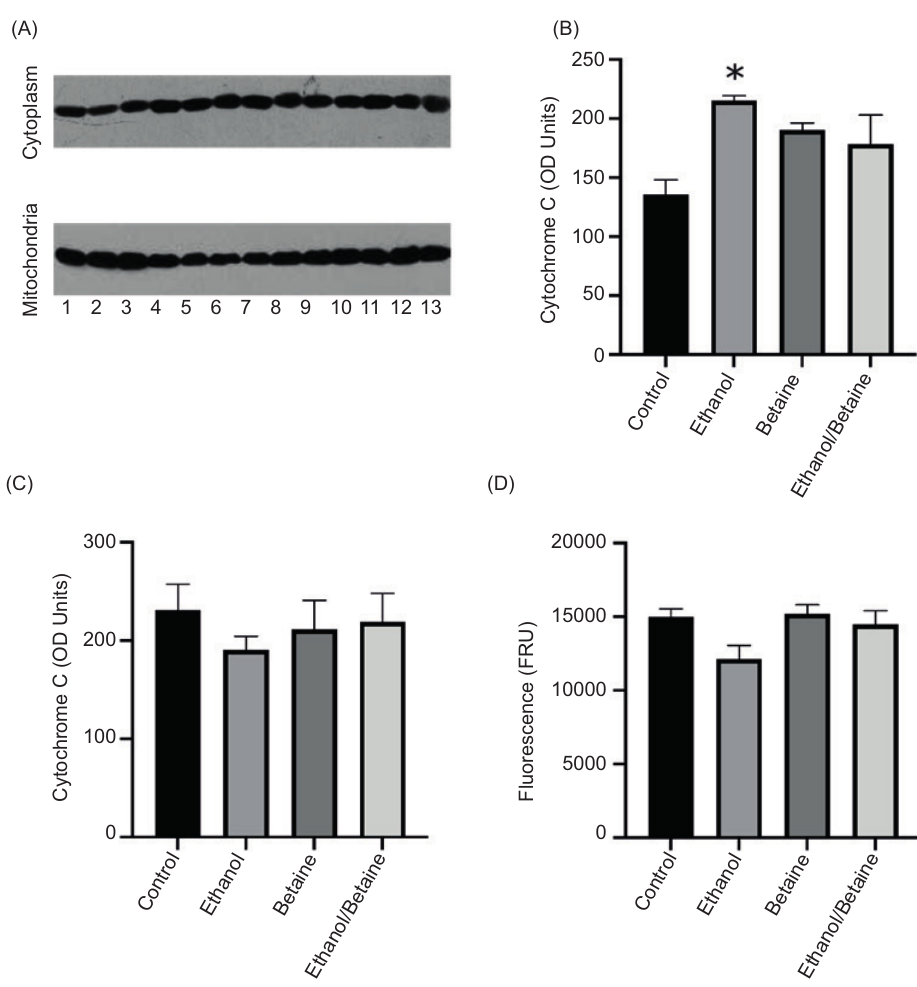
Figure 1: The effect of betaine on ethanol-induced changes in (A) cytosolic and mitochondrial cytochrome c detection, (B) cyto- solic cytochrome c levels, (C) mitochondrial cytochrome c levels, and (D) caspase-3 activity. Cytochrome c levels were detected by Western blotting. Lanes 1–3 = control; Lanes 4–7 = ethanol; Lanes 8–10 = betaine; Lanes 11–13 = betaine and ethanol. Caspase-3 activity in 25 µg of cytosolic protein was determined based on the cleavage of Ac-DEVD-AFC (3 mg/mL) to AFC. Values are expressed as mean ± SEM (n = 3–4). *P < 0.05 compared to